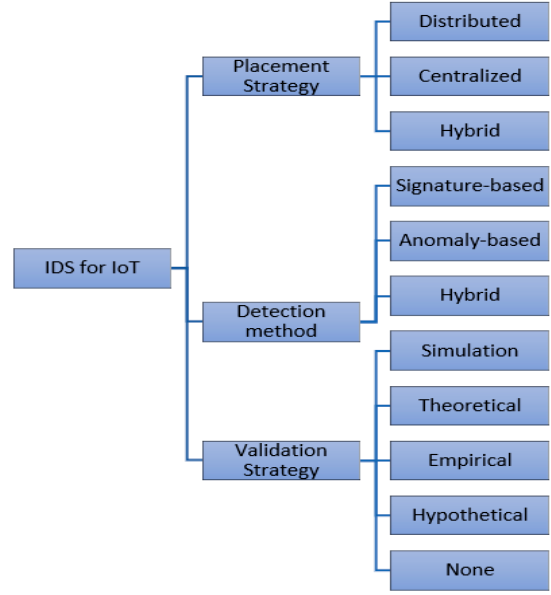
Figure 2. Classification of Intrusion Detection Systems for IoT.